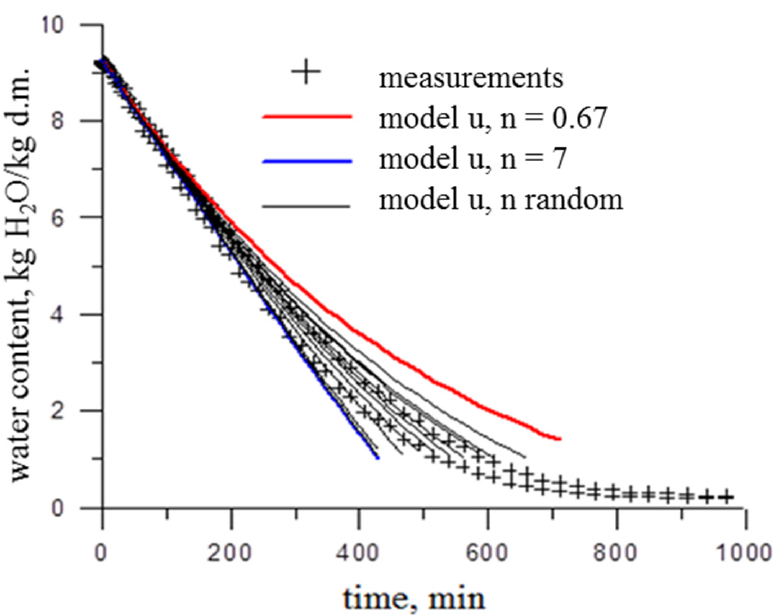
Figure 7. The graphs of models for moisture content changes with random coefficient for leek slices 4 mm thick, during drying at temperature 50 °C.